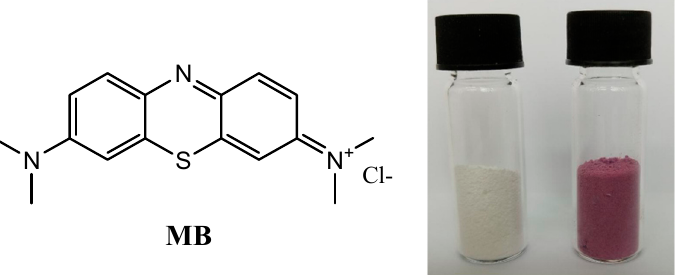
Figure 1. Chemical structure of MB ( left ), titania nanoparticles, and the obtained Au NPs deposited in titania ( right ).